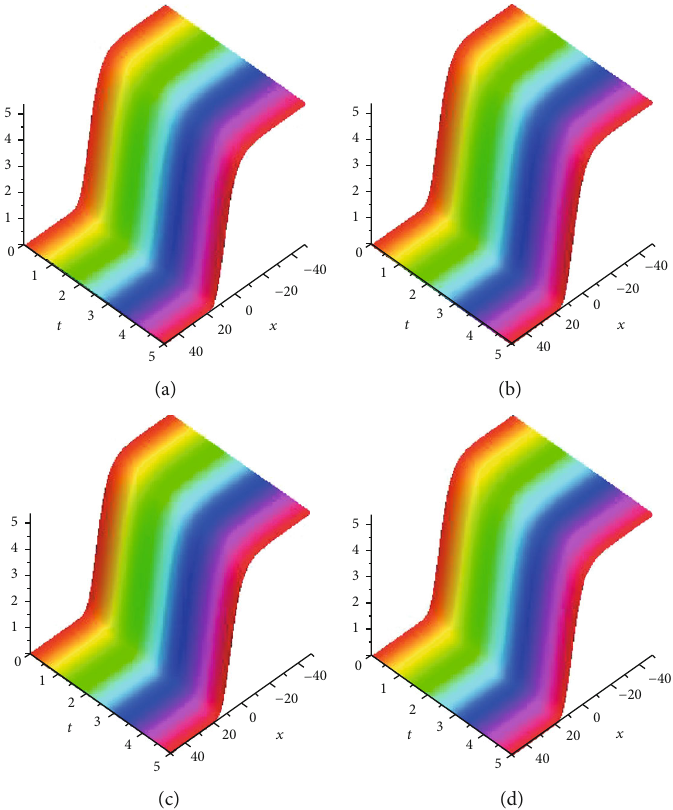
= 1 : 5 , q = 2 , λ = 2 : 2 , M = 3 , N = 2 , and k = 3 when (a) α = 0 : 25 , (b) α = 0 : 5 , (c) α = 0 : 85 , 2 2